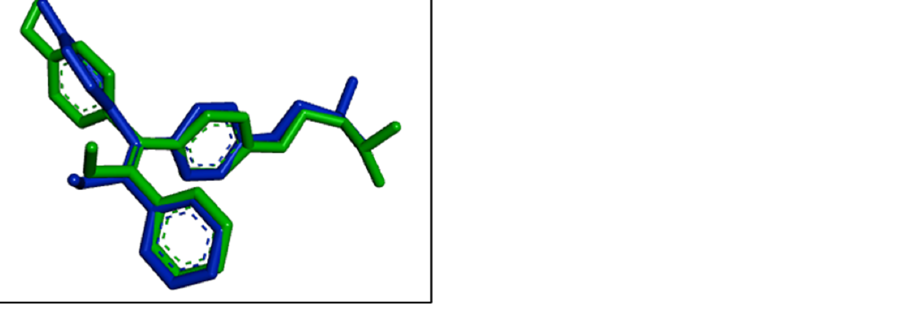
Figure 4. The superimposition in the binding position of the cocrystallized hydroxytamoxifen (blue colored) and computationally obtained binding position of hydroxytamoxifen (green colored).